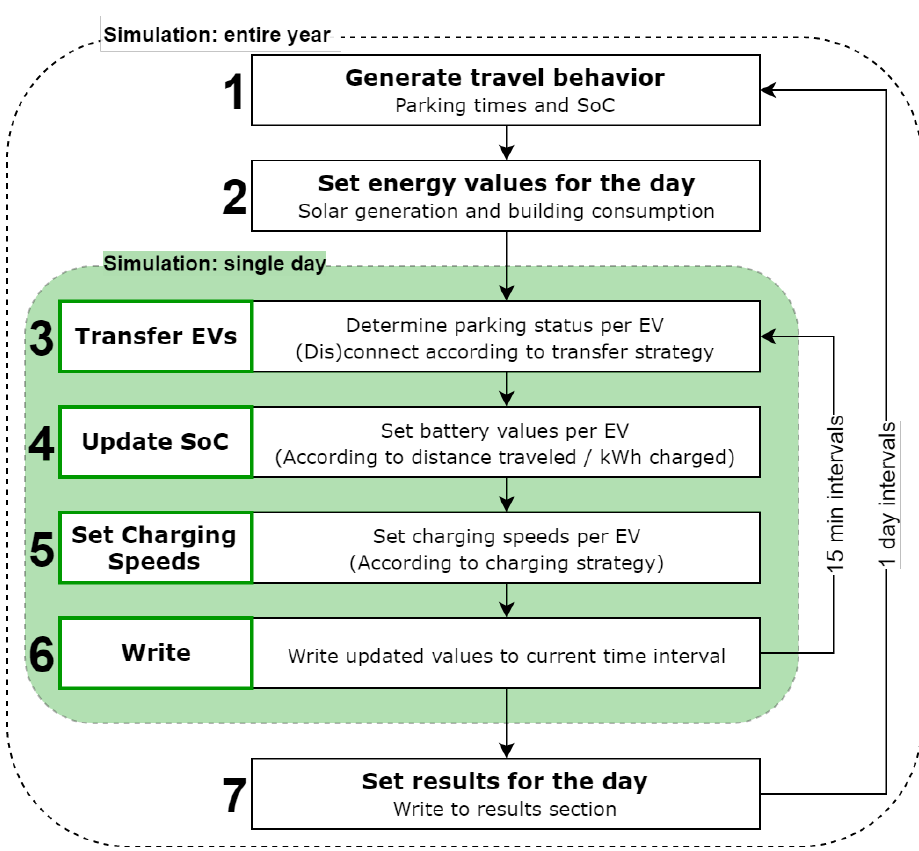
Figure 8. Simulation steps for an entire year or a single day with 15 min